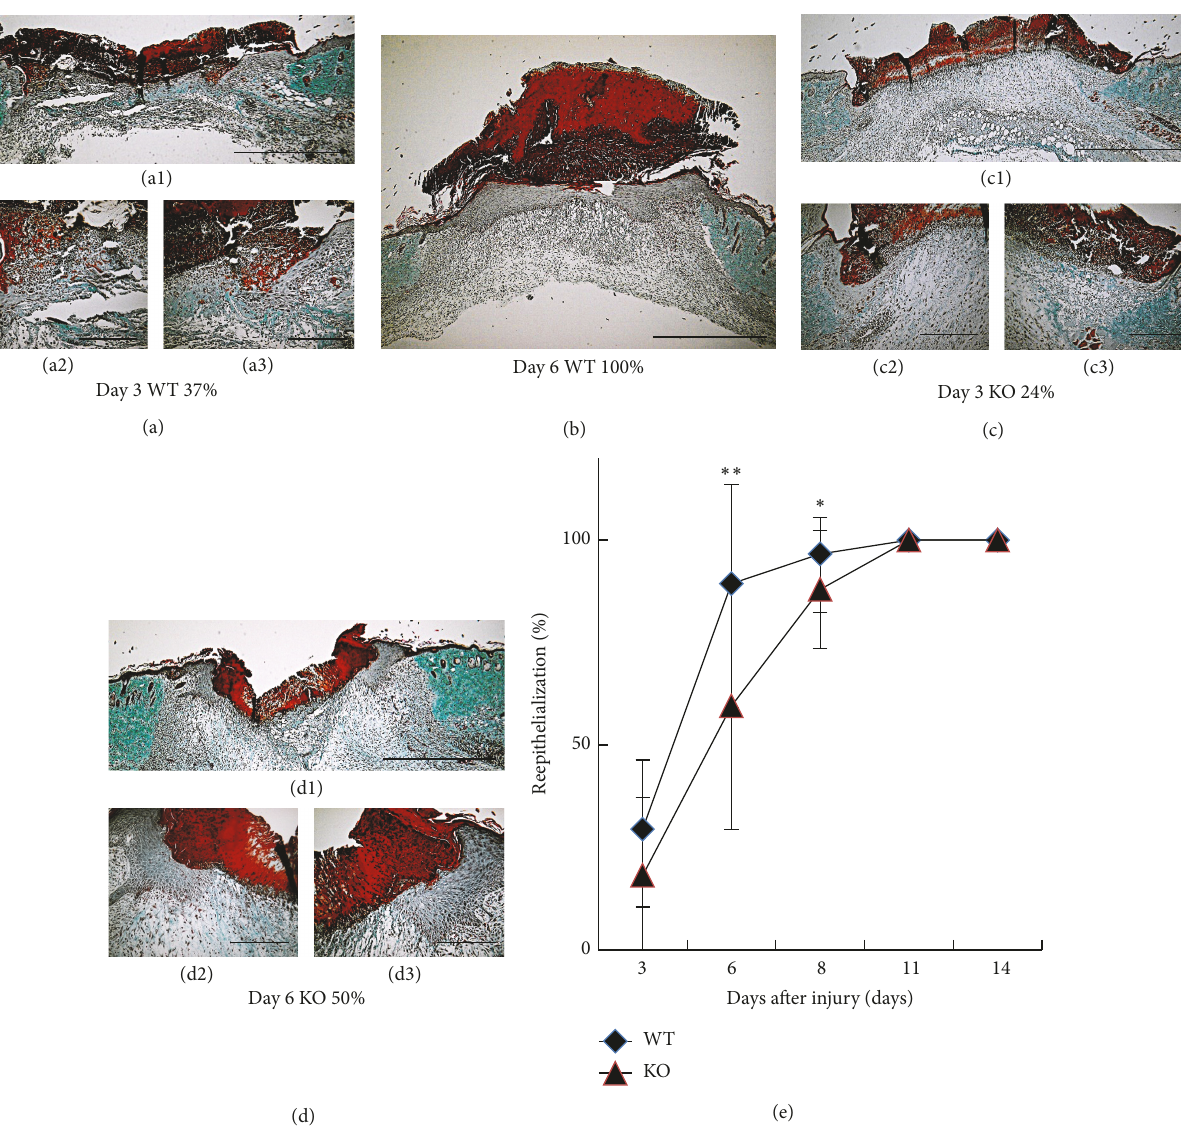
Figure 3: (a–d) Histological observation of reepithelialization of skin wound in wild type (WT) ((a1)–(a3), b) and inducible nitric oxide synthase (iNOS-) knockout (KO) ((c1)–(c3), (d1)–(d3)) mice at day 3 ((a1)–(a3), (c1)–(c3)) and day 6 (b, (d1)–(d3)) after injury. Masson- Goldner trichrome stain was viewed at low and high magnification to measure the original wound distance and reepithelialization area, respectively. (e) The ratio of reepithelialization was evaluated. Reepithelialization was significantly delayed in KO mice at days 6 and 8 with statistical difference compared with WT mice. X : WT, 󳵳 : KO (days 3, 11, and 14: 𝑛 = 6 ; days 6, 8: 𝑛 = 7 animals in each group). Mean ± standard deviation. ∗ 𝑝 < 0.05 ; ∗∗ 𝑝 < 0.01 ; bar, 1mm (a1, b, c1, and d1), 200 𝜇 m ((a2)-(a3), (c2)-(c3), and